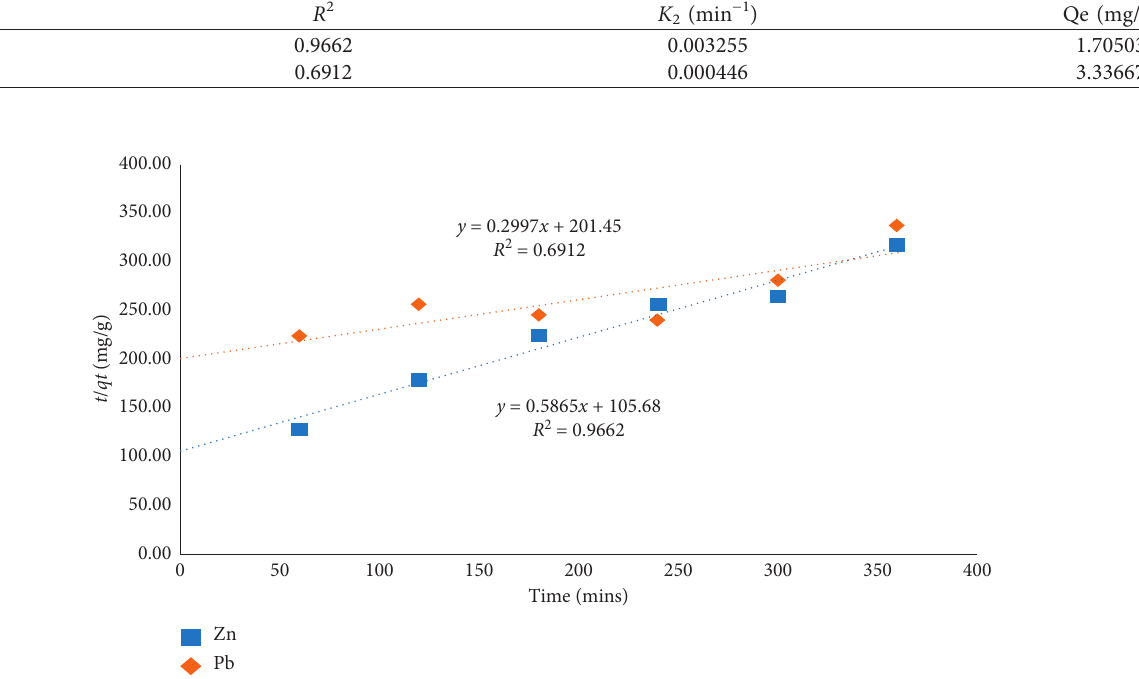
Figure 10: A graphical presentation of the pseudo-second-order reaction kinetic